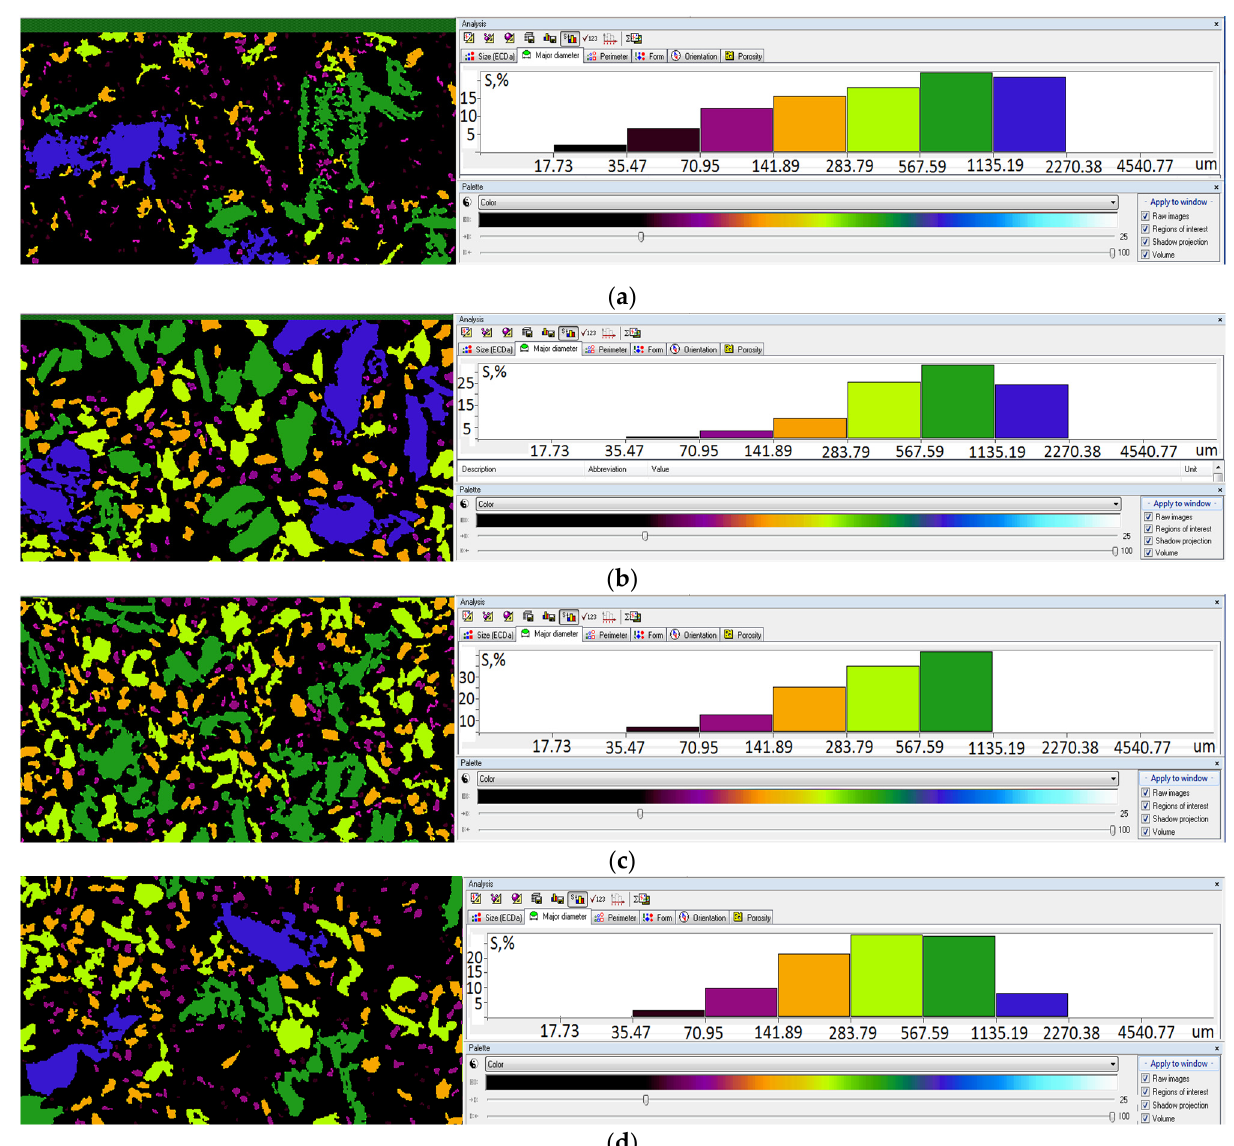
Figure 2. A diagram of the granulometric composition of the mushroom powders based on microtomographic data of the particle size in the program CTAn: ( a ) FD; ( b ) HAD; ( с ) MWD; ( d ) SD.